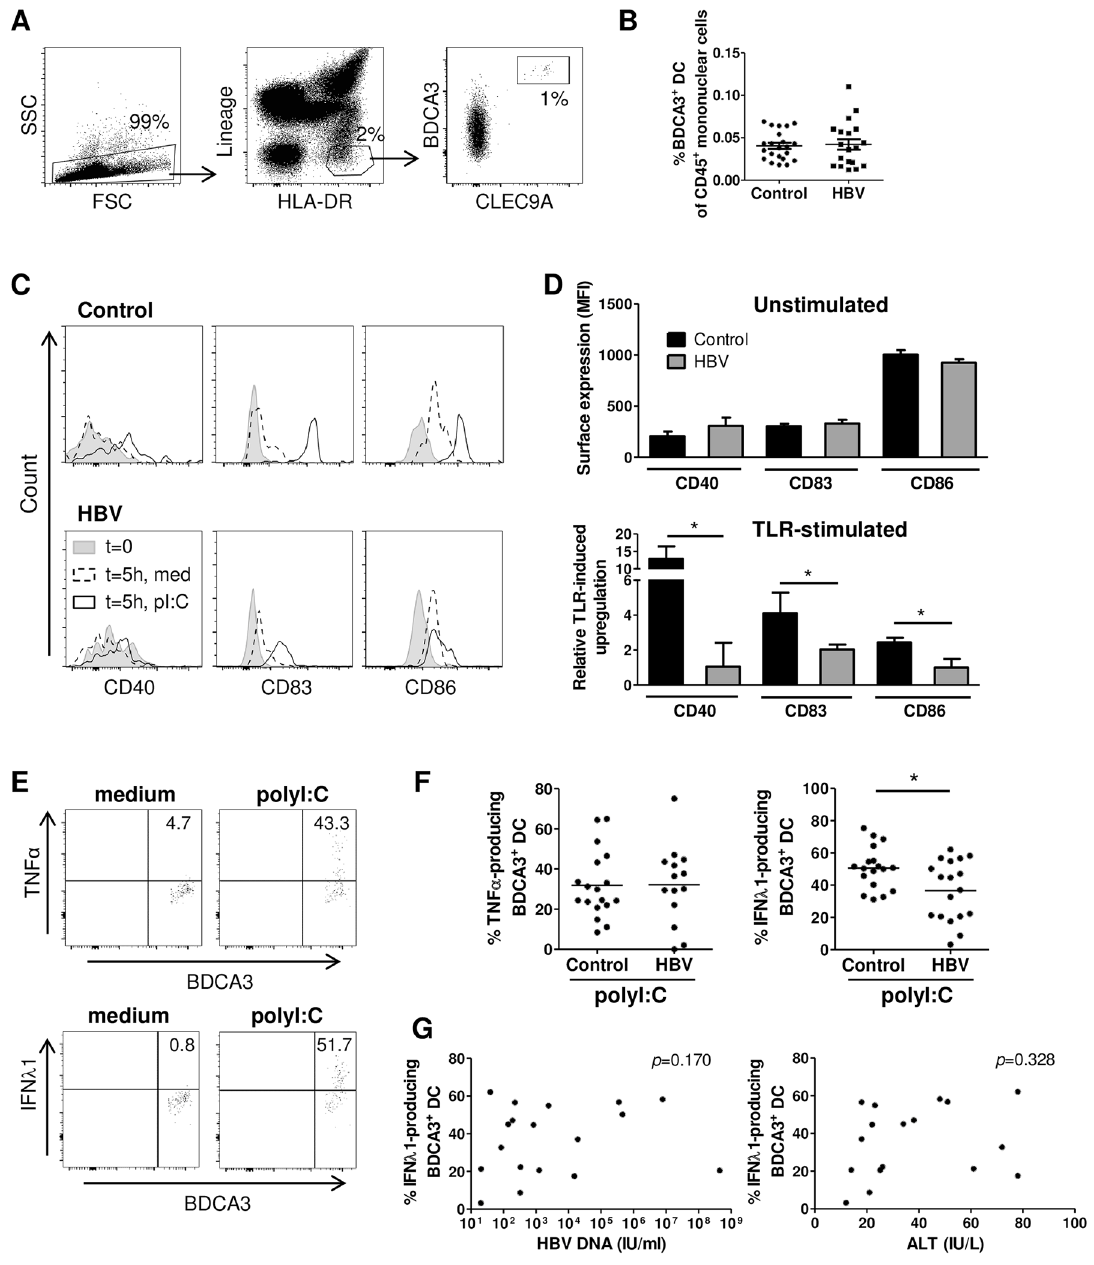
Fig 2. Blood BDCA3 + DCs from CHB patients are impaired in their capacity to mature and produce IFN- λ . PBMC were isolated from CHB patients and healthy controls. (A-B) The DC population was identified as Lineage - HLA-DR + mononuclear cells, within which BDCA3 + CLEC9A + DCs were detected. (A) Representative flow cytometry plots and (B) the percentage of BDCA3 + DCs of CD45 + mononuclear cells (control n = 22, HBV n = 19; mean ± SEM). PBMCs were stimulated for 5 hours with or without polyI:C. Expression of the maturation markers CD40, CD83 and CD86, and cytokine production by BDCA3 + DCs was measured by flow cytometry. (C) Representative histograms of maturation marker expression by BDCA3 + DCs. (D) Collected expression data (MFI) for each marker after isolation at t = 0 (Unstimulated), and relative upregulation after stimulation compared to the medium control at t = 5 (TLR-stimulated) (control n = 15, HBV n = 8) (mean ± SEM). (E) Representative flow cytometry plots of TNF α and IFN- λ 1 production by FSC/SSC gated viable BDCA3 + DC. (F) Collected percentages of TNF α - producing and IFN- λ 1-producing BDCA3 + DCs in controls (n = 18) and HBV patients (n = 18) (mean ± SEM). * p < 0.05 by Mann- Whitney test. (G) Spearman ’ s correlation between the frequency of IFN- λ 1-producing BDCA3 + DCs from HBV patients and serum HBV DNA or serum ALT levels (n = 18).